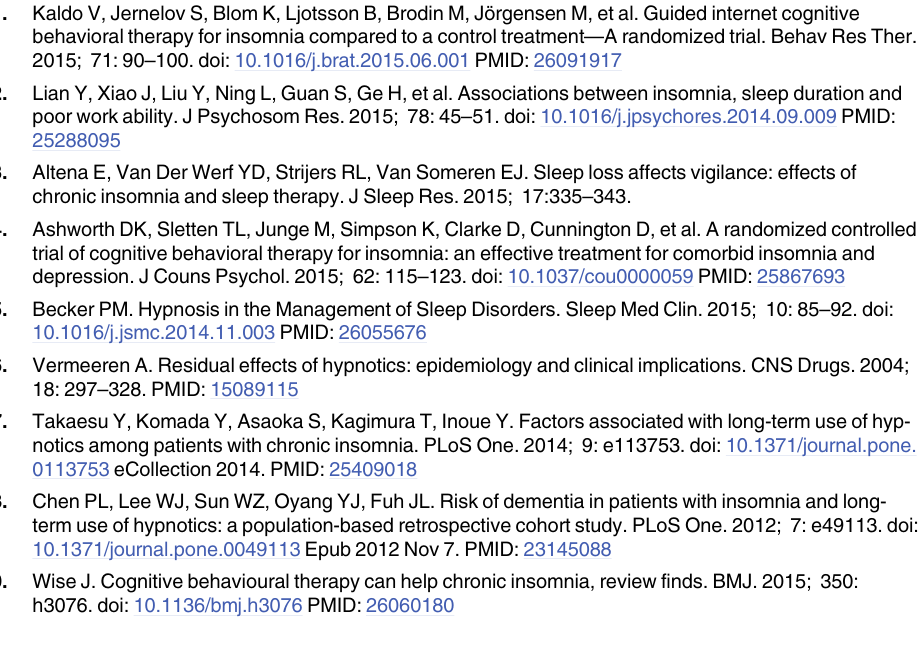
S1 Fig. Sensitivity analysis of the effects of ICBT-i on anxiety and depression. S2 Fig. Funnel plot of publication bias (ICBT-i on anxiety and